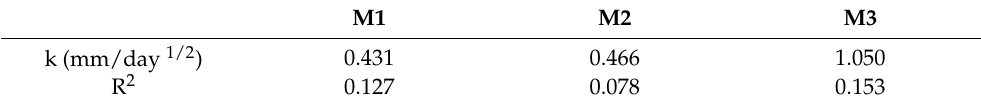
Table 11. k coefficient of cement mortars exposed to accelerated carbonation. M1 M2 M3 k (mm/day 1/2 )